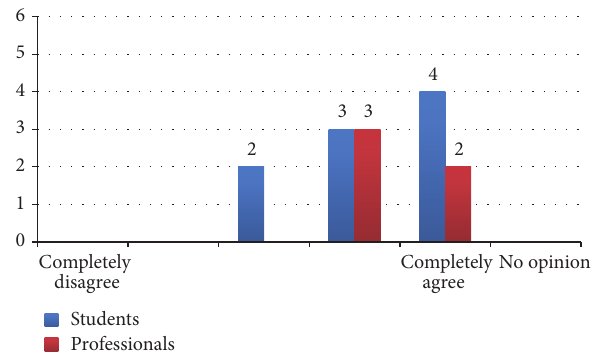
Figure 15: Statement: I can imagine using ECW/PUEA in future